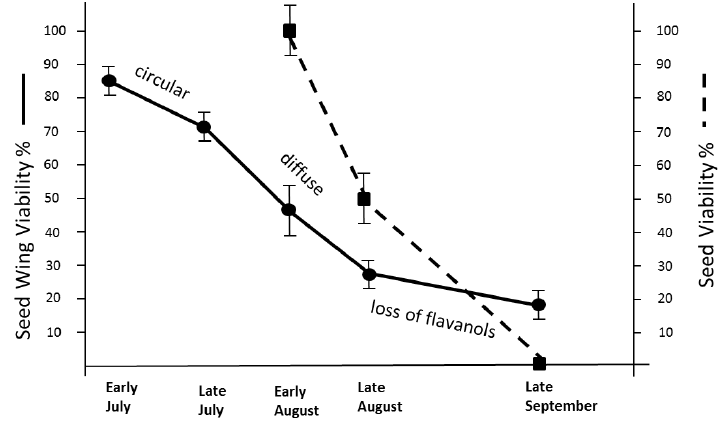
Figure 4. Loss of the globular shape of the nuclei from seed wings